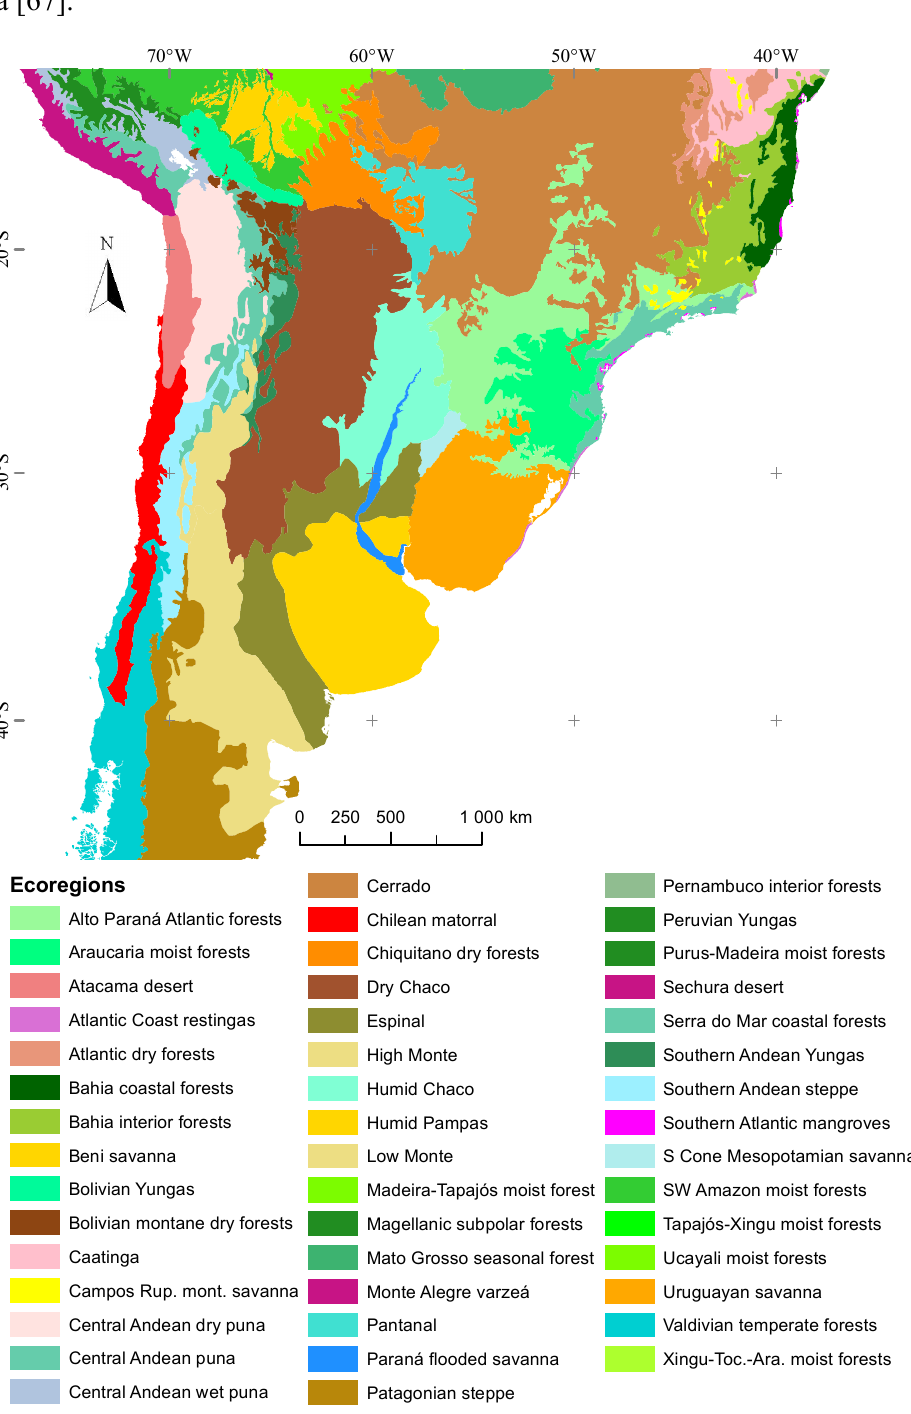
Figure 1. Study area showing the World Wildlife Foundation Ecoregions map of South America